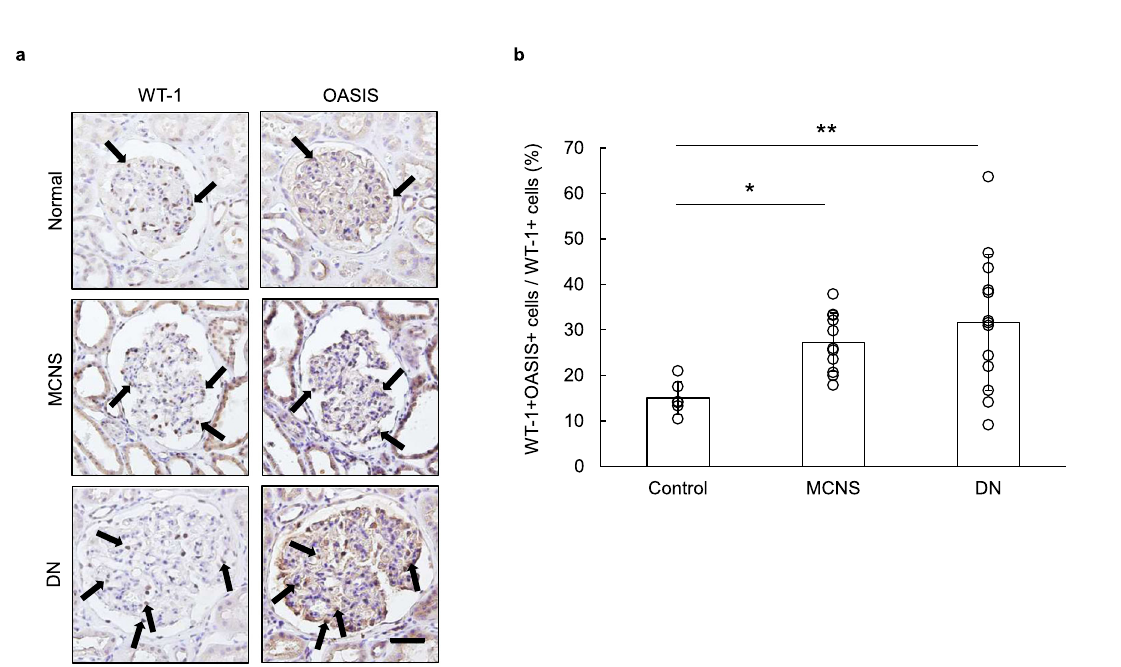
Fig. 7 OASIS-positive podocytes were increased in the glomeruli of patients with human minimal change nephrotic syndrome and diabetic nephropathy. a Immunohistochemical staining of kidneys from patients with MCNS and DN was performed using an anti-WT-1 or anti-OASIS antibody. Nuclei were stained with hematoxylin. Representative images are shown. Arrows: WT-1- and OASIS-positive cells. Scale bar: 100 µ m. b The rate of